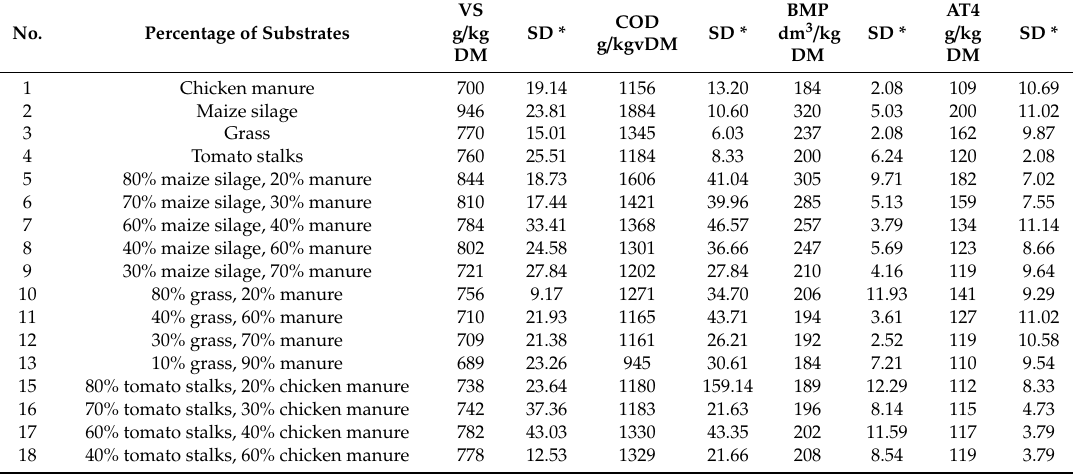
Table 1. The physico-chemical composition of the substrates and their susceptibility to biological decomposition. AT4: aerobic, BMP: biochemical methane potential, COD: chemical oxygen demand. VS No. Percentage of Substrates g /